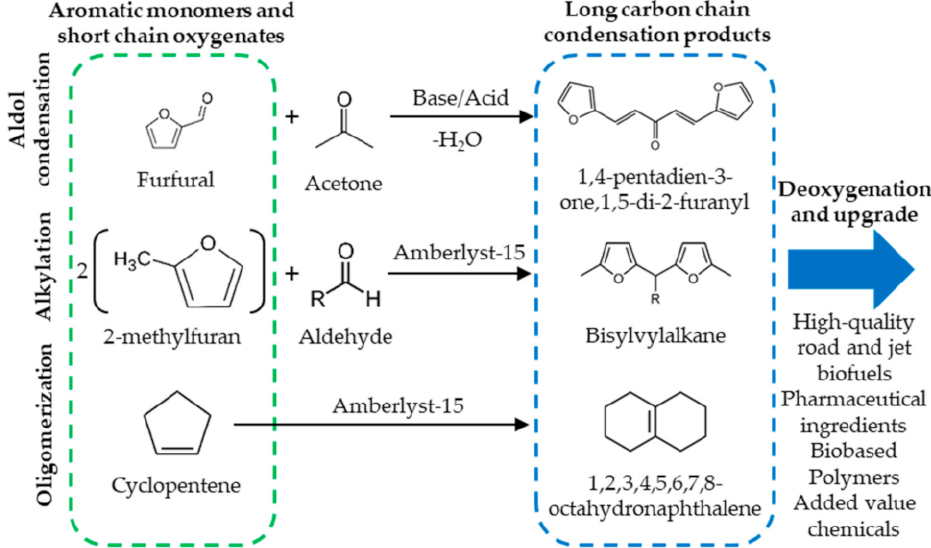
Figure 4. Representative C-C coupling reactions for the synthesis of long carbon chain oxygenates: Aldol condensation [6], oligomerization [140], and hydroxyalkylation/alkylation